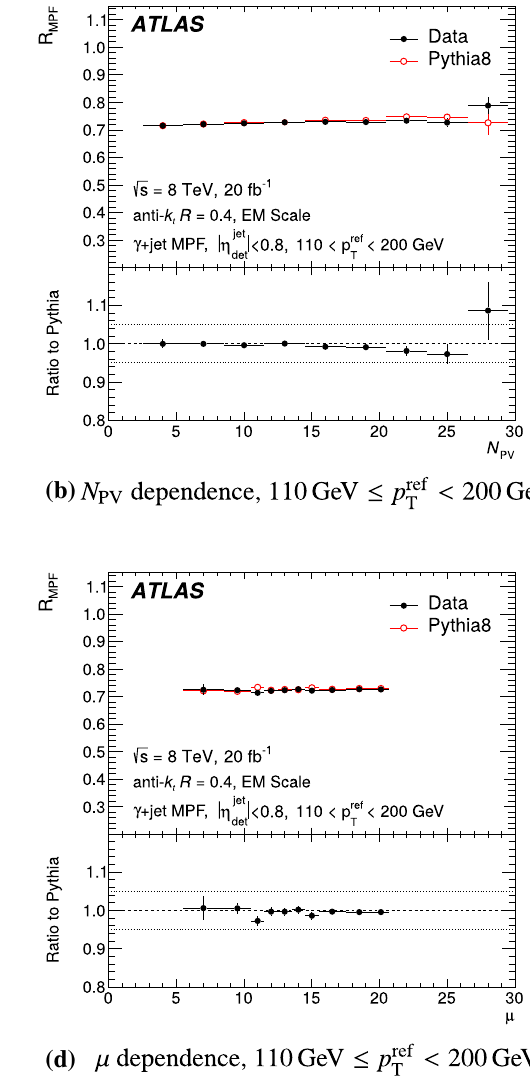
< 65GeV and b , a reference p T range of a , c 45GeV ≤ p ref T < 200GeV. Only statistical uncertainties are d 110GeV ≤ p ref T